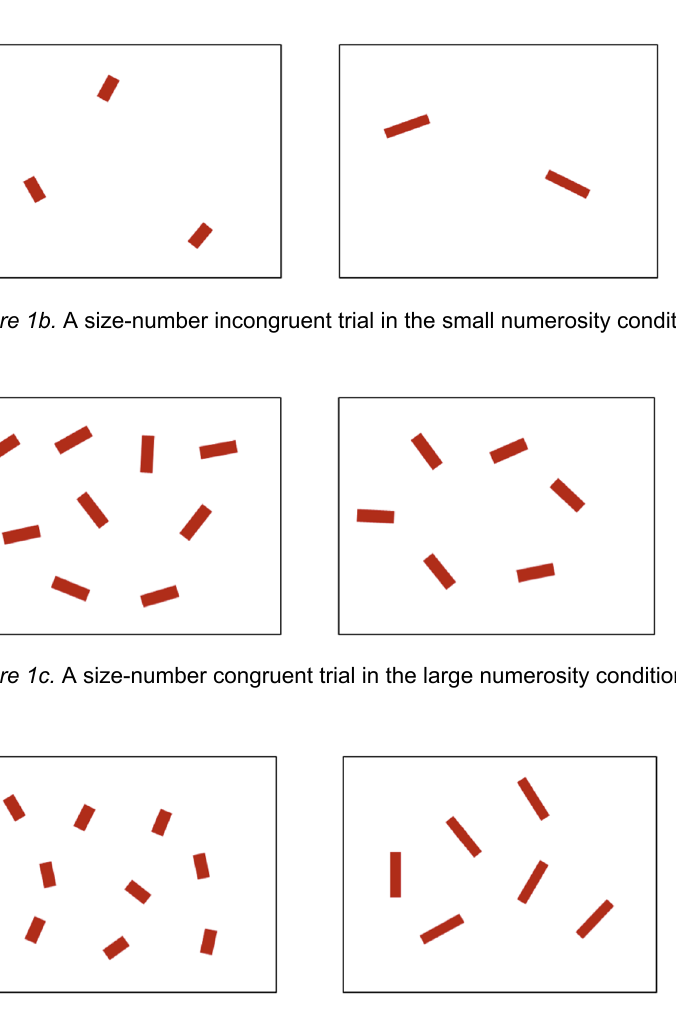
Figure 1d. A size-number incongruent trial in the large numerosity condition in Experiment